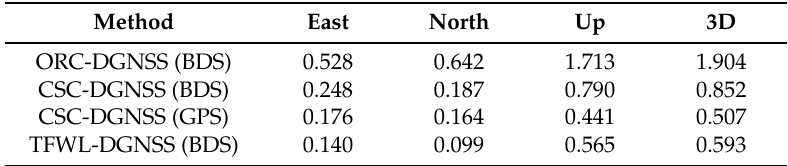
Table 10. Averaged RMS of CSC-DGNSS and TFWL-DGNSS. Units are in